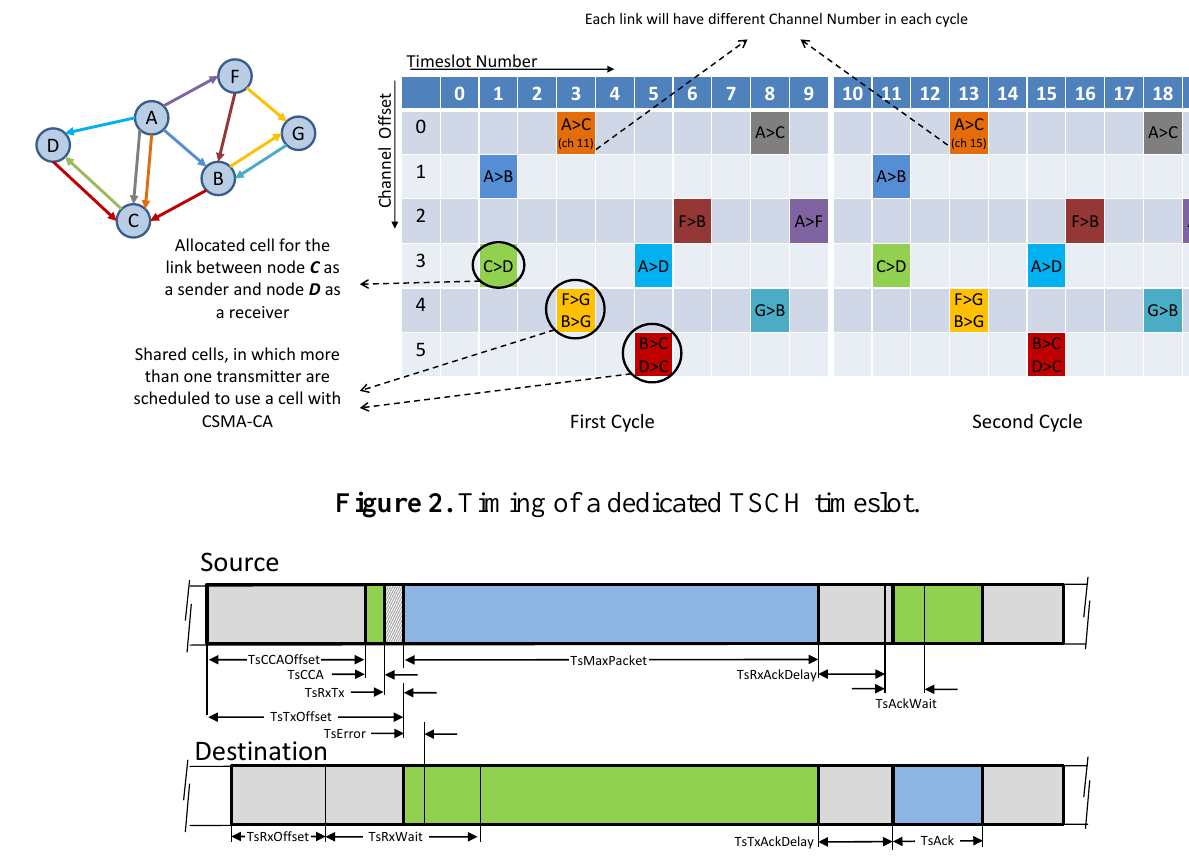
Figure 1. TSCH Slot-channel matrix (right) for the network shown on the left.